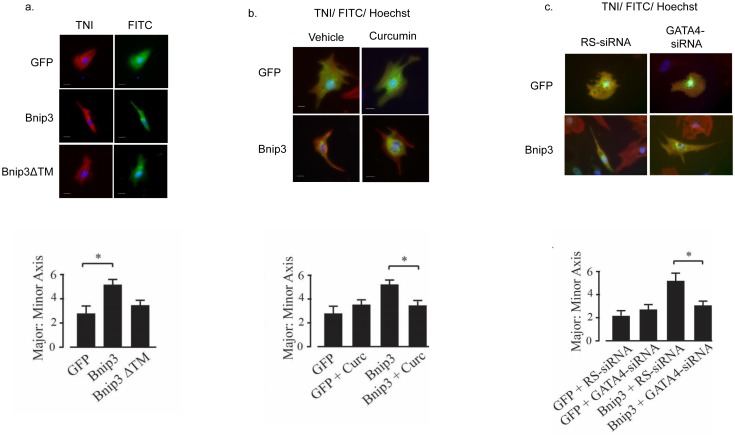
Curcumin and GATA4 sensitive changes in myocyte morphology.In (A) cardiac myocytes were transfected with expression plasmids for GFP, Bnip3, or Bnip3ΔTM and the ratio of the cell length to width determined. Myocyte identity was confirmed by troponin (TNI) immunocytochemistry. Quantitative analysis of the major to minor axis ratio is shown below. The effect of curcumin (Curc) on the major to minor axis ratio is shown in (B) with quantitative analysis of the major to minor axis ratio again shown below. The effect of GATA4 and random (RS) siRNA on the major to minor axis ratio is shown in (C) with quantitative analysis of the major to minor axis ratio also shown below. Results are mean ± S.E.M., significantly different then controls (p < 0.05), n = 3.